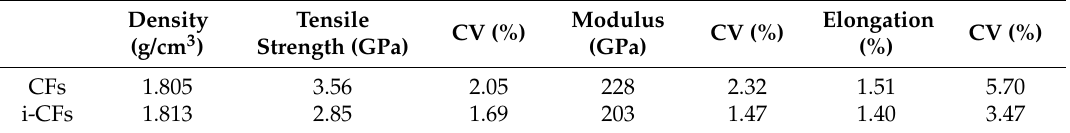
Table 3. Densities and mechanical properties of PAN-based carbon fibers and irradiated-PAN-based carbon fibers with the corresponding coefficient of variance (CV). i-CF, irradiated carbon fiber.